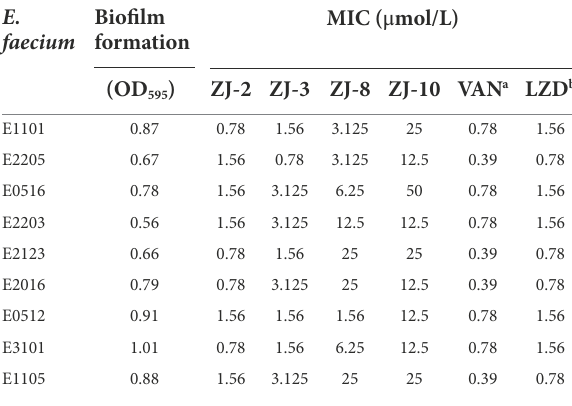
TABLE 2 MIC and biofilm formation values for the clinical isolates Enterococcus faecium .